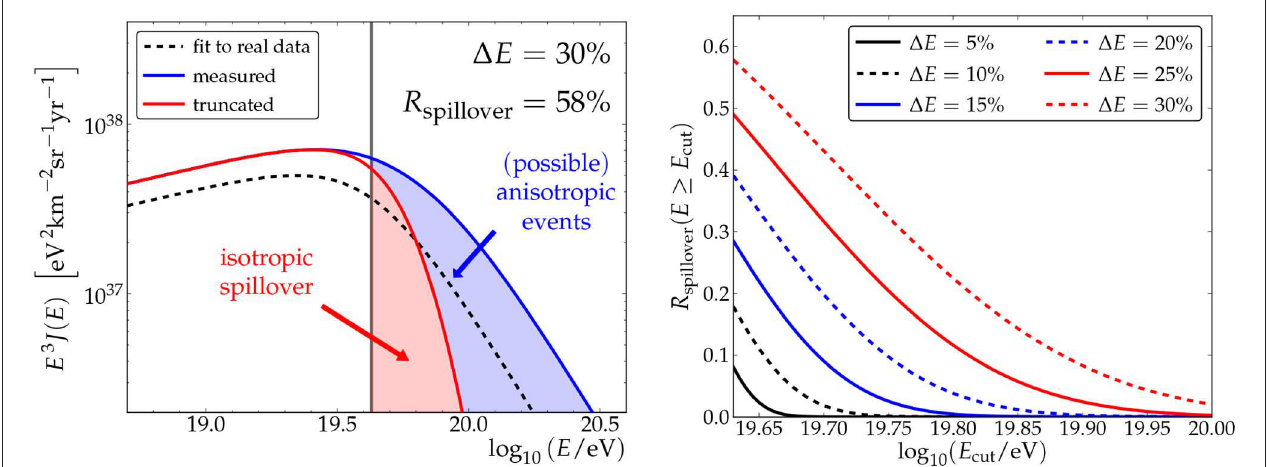
FIGURE 8 | Effect of spillover. Left: The dashed line represents the true energy spectrum, the blue line shows the observed one measured for energy resolution of 30%, and the red curve shows the distribution of unwanted spillover events leaking into the sample of events above an applied threshold (vertical line). Right: Evolution of the spillover ratio as a function of the cut energy. Shown are ratios for six different energy resolutions. The respective intersection with the y -axis represents the ratio calculated without applying an additional energy cut in data. Reproduced with permission from Brümmel et al. (2013).